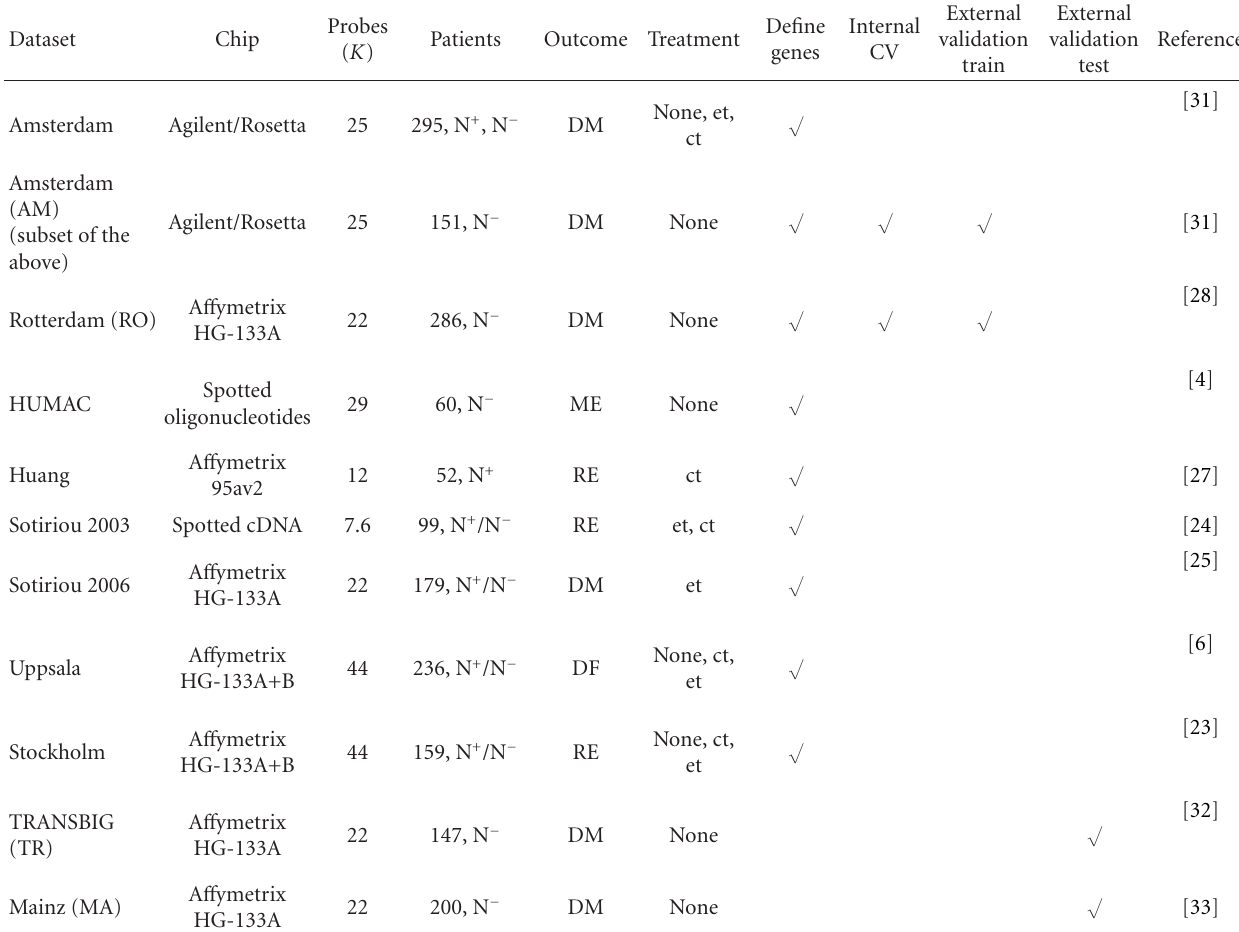
Table 1: Overview of datasets